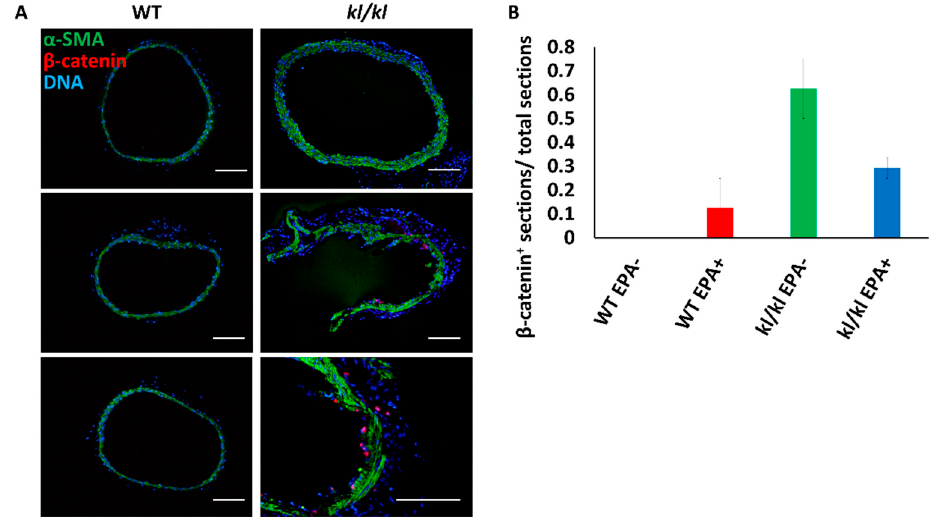
Figure 2. Beta-catenin expression in aortas of mice. ( A ) Immunostaining of mouse aortas: green, α -smooth muscle actin ( α -SMA); red, β -catenin; and blue, DNA; ( B ) Proportions of β -catenin-positive aorta sections (total numbers of sections: Wild-type (WT) mice fed control diet, n = 7; WT mice fed EPA diet, n = 6; kl / kl mice fed control diet, n = 6; and kl / kl mice fed EPA diet, n = 7). Bar = 100 μ m.